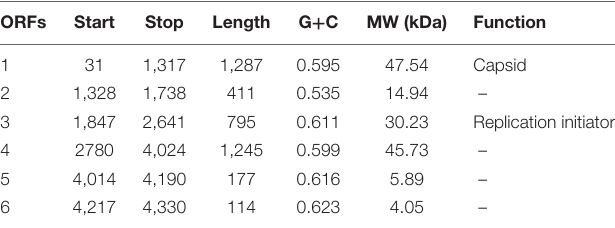
TABLE 1 | Predicted ORFs and their annotation.